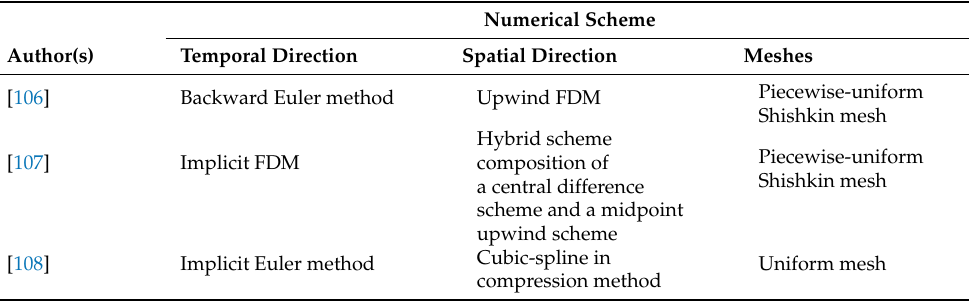
Table 15. Various methods and mesh used to solve Equations